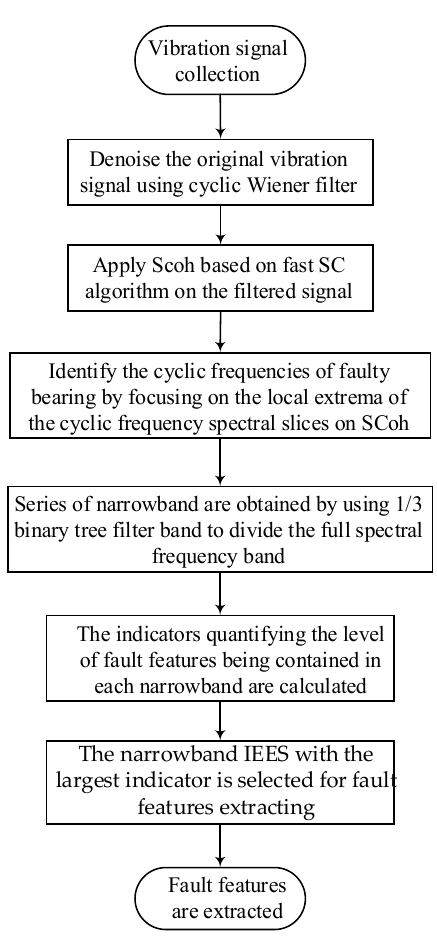
Figure 2. Flowchart of the proposed method.